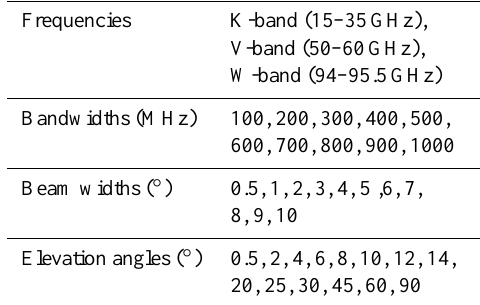
Table 2. Summary of the instrument characteristics included in the study.